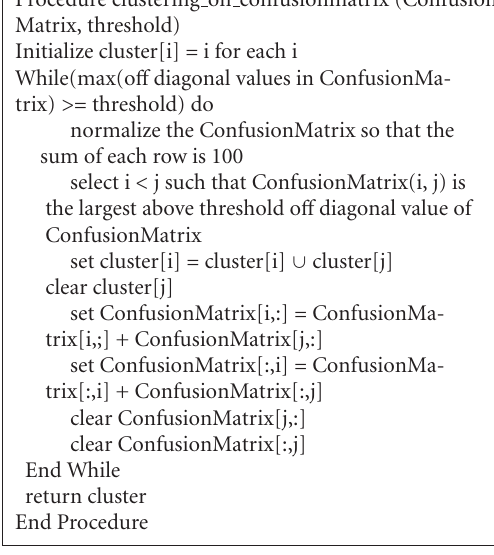
Algorithm 1. Procedure: clustering on confusionmatrix (Con- fusionMatrix,